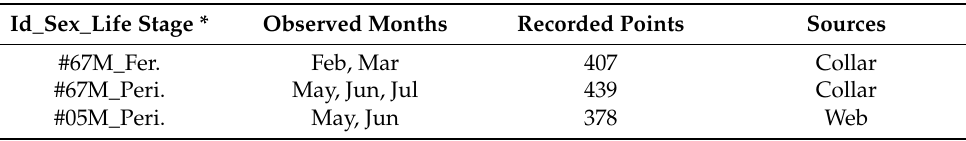
Table A1. Individual identification (Id), life stages, observed months, and the number of recorded points for wild boar movements based on telemetry data during the survey